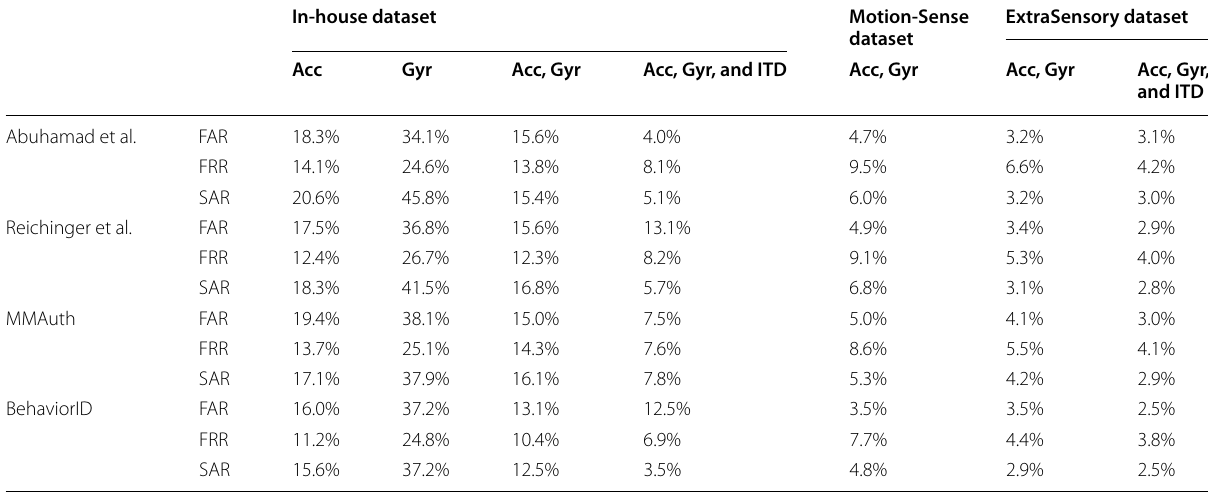
ExtraSensory dataset dataset Acc, Gyr, and ITD